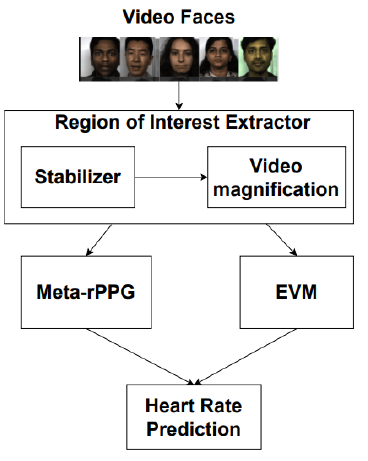
Figure 1. Methodology